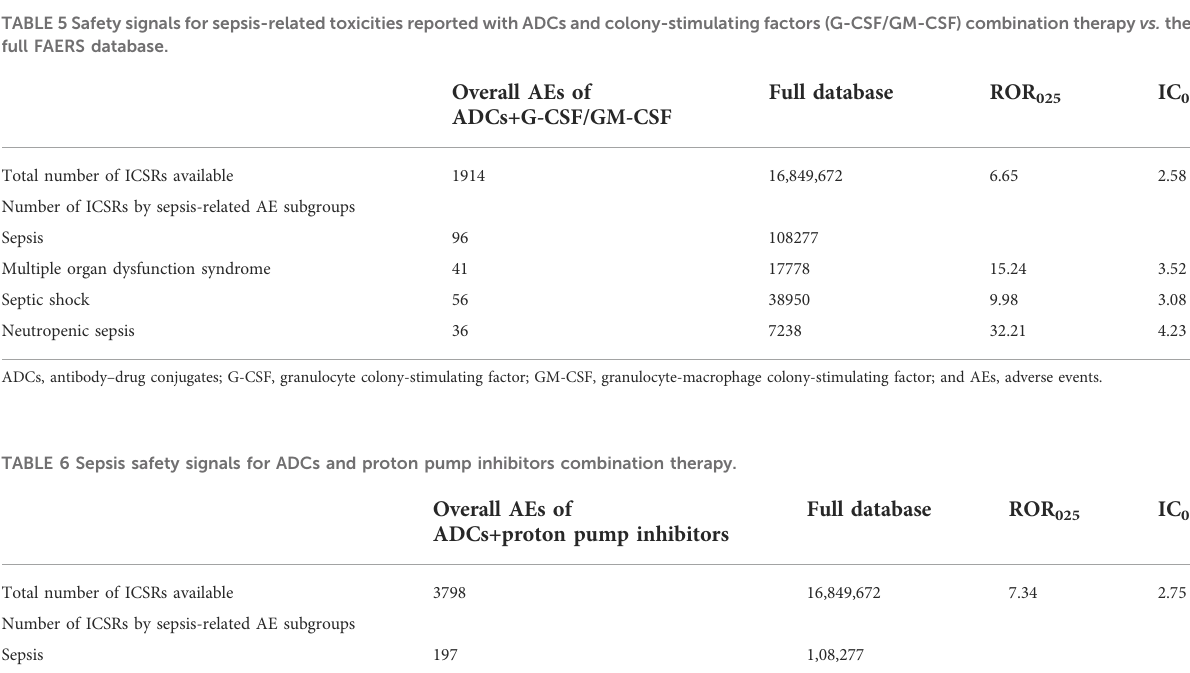
TABLE 5 Safety signals for sepsis-related toxicities reported with ADCs and colony-stimulating factors (G-CSF/GM-CSF) combination therapy vs. the full FAERS database.